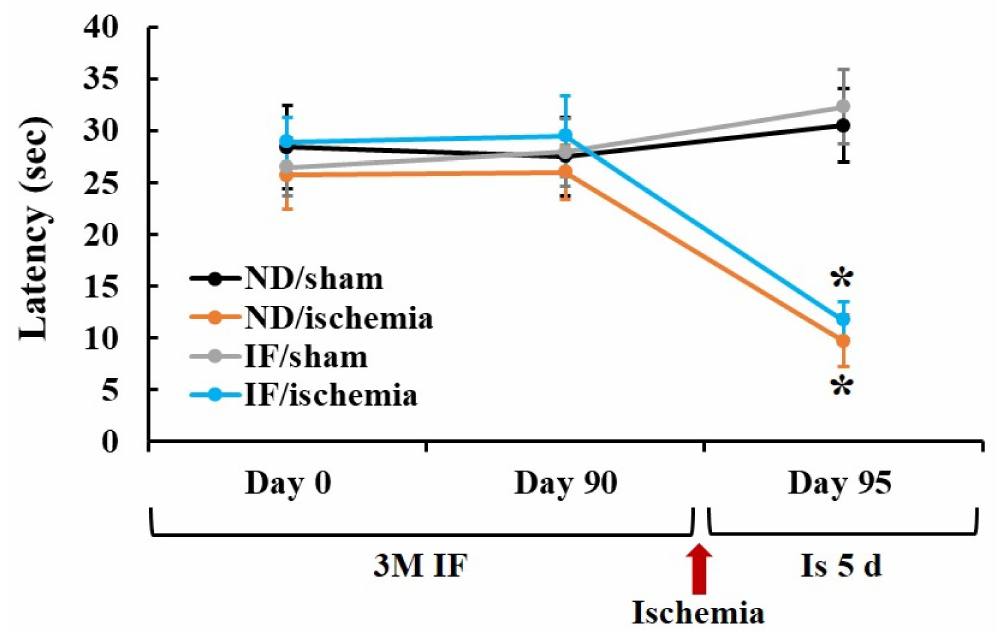
Figure 1. Short-term memory tests using passive avoidance test in the ND/sham, IF/sham, ND/ischemia and IF/ischemia groups. The latency time before and after 3-month IF in both sham groups is not altered. In addition, there is no difference in latency time at 5 days post-ischemia between the ND/ischemia and IF/ischemia groups ( n = 7 per group; * p < 0.05, vs. ND/sham group by post hoc Tukey’s test). Bars indicate means ± SEM. IF, intermittent fasting; ND, normal